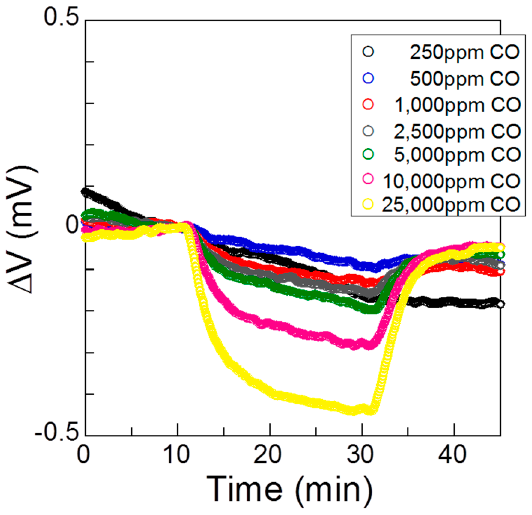
Figure 6. Sensor responses to different concentrations of CO in humid air at 120 °C.